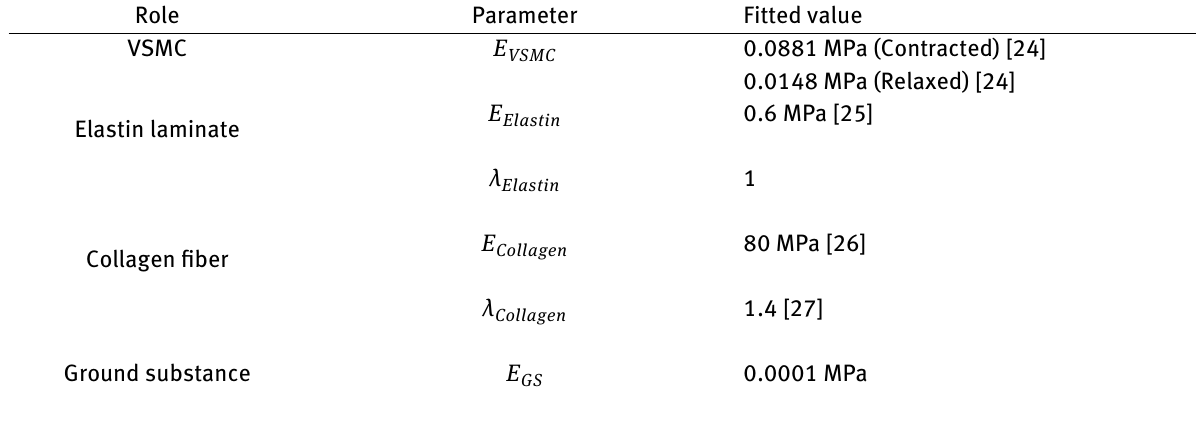
Table 2: Mechanical properties of